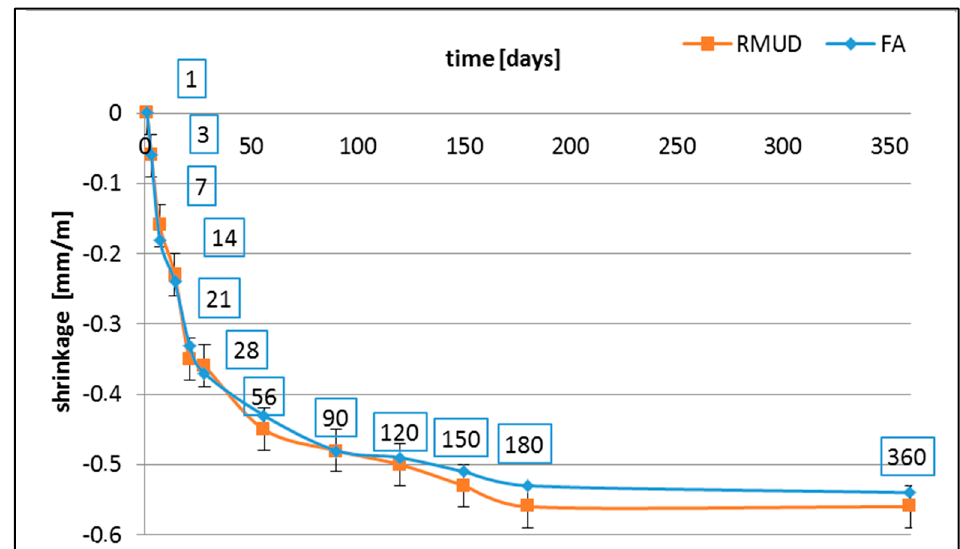
Figure 4. Results of shrinkage tests.